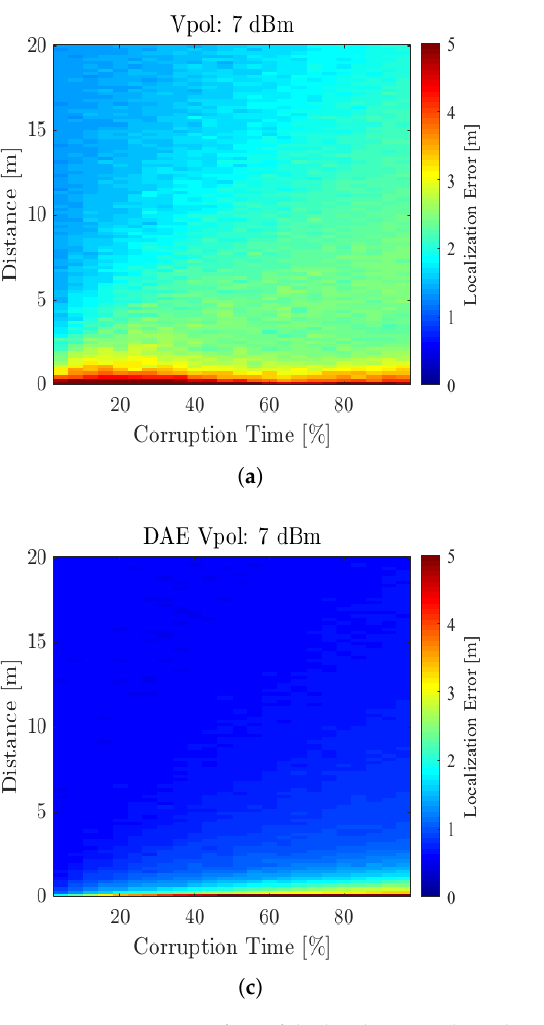
Figure 8. Error surface of the localization algorithms for increased interference distances and corruption times and the simultaneous effect on 3D CSI extraction of a vertically polarized target emitter with interference power levels of ( a ) 7 dBm 3D CSI, ( b ) 13 dBm 3D CSI, ( c ) 7 dBm DAE 3D CSI, and ( d ) 13 dBm DAE 3D